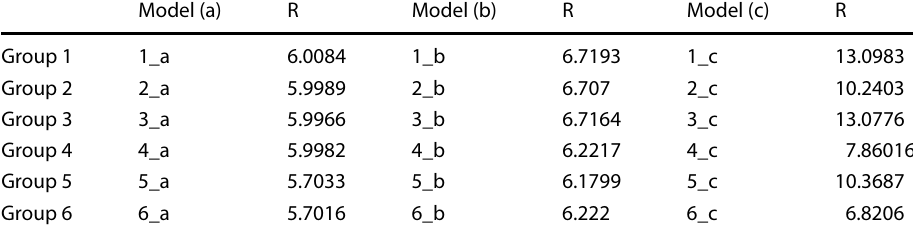
Table 7 The response modification factors of 8-story 3-span